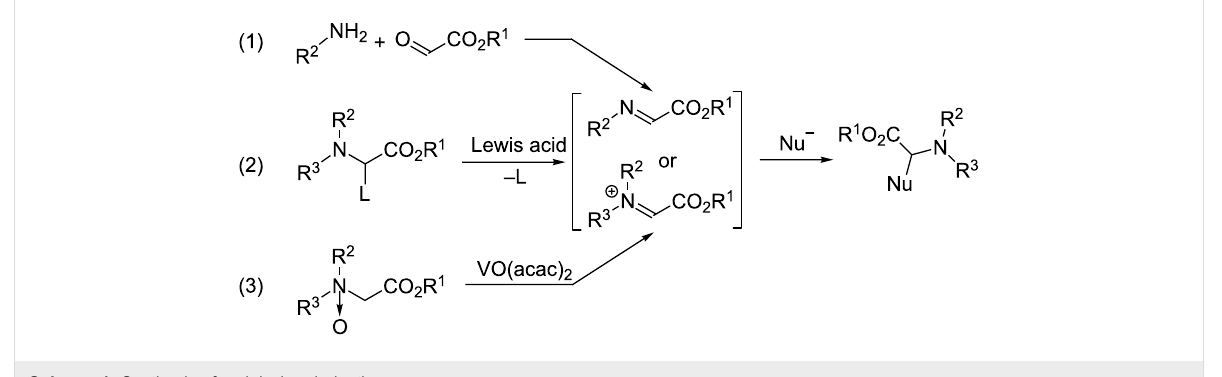
Scheme 1: Synthesis of arylglycine derivatives.